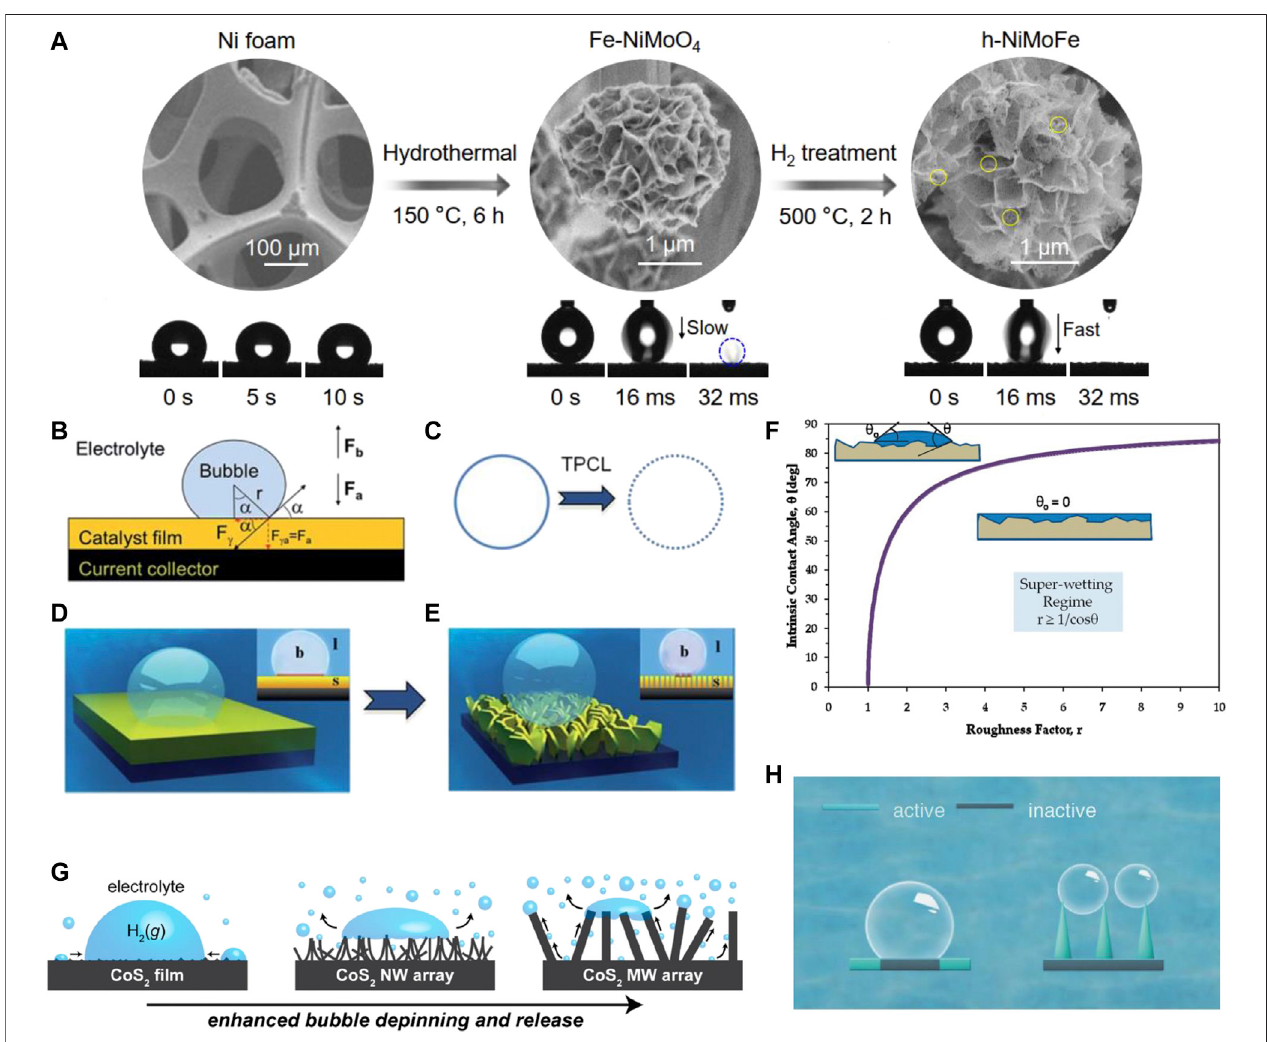
FIGURE 1 | (A) Synthesis of the h-NiMoFe catalyst and wettability characterization on different samples, reproduced with permission from Luo et al. (2021). (B) Force analysis of a single bubble on the catalyst fi lm; (C) triple-phase contact lines (TPCLs) on different electrode states: fl at (left) and nanostructured (right) (D,E) schematic illustration of the adhesion behavior of bubbles on different electrode states: fl at fi lm (left) and nanostructured fi lm (right), reproduced with permission from Lu etal.(2015). (F) Minimumvaluesoftheroughnesscoef fi cientnecessarytofacilitatecompletediffusionoftheliquidonthesurface,reproducedwithpermissionfrom Drelich and Chibowski (2010). (G) Schematic diagram of the evolutionary behavior of bubbles formed on CoS 2 fi lms with different surface structures, reproduced with permission from Faber et al. (2014). (H) Schematic illustration of bubble and catalysts contact, reproduced with permission from Xie et al. (2021).